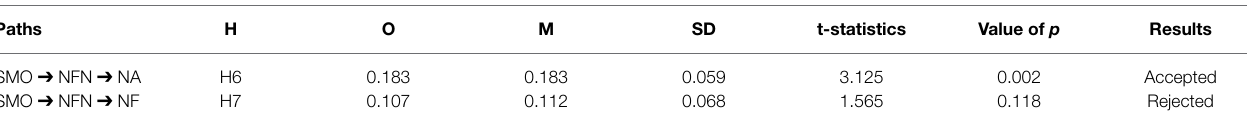
TABLE 7 | Indirect effects of the variable.